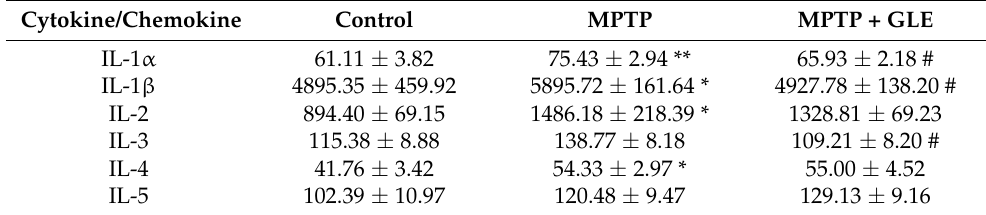
Table 2. Mouse striatum cytokine/chemokine concentrations 1